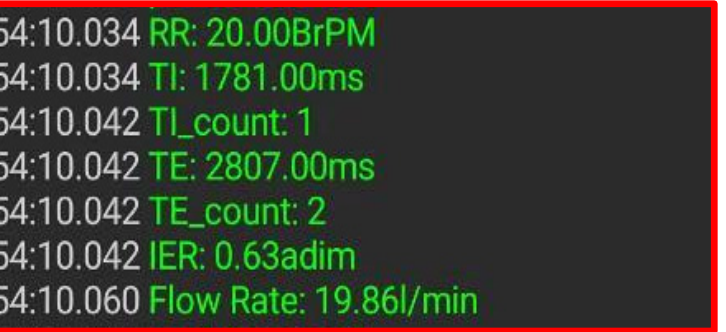
Figure 6. Breathing parameters measured by the chest band shown by the Bluetooth serial monitor application.